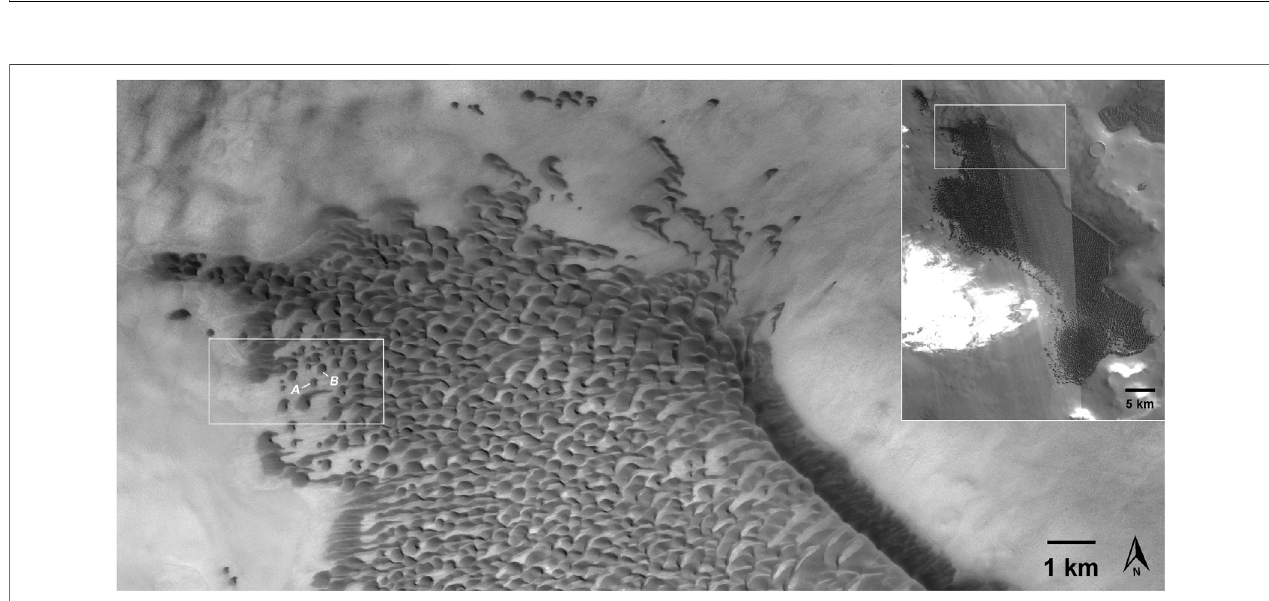
FIGURE3| Thenorthernendofthedune fi eld(CTXimageJ22_053517_2571),contextshownintheinset.Theboxindicatesthelocationof Figure1 ,andDunesA and B are indicated. The fi gure was made using JMARS (Christensen et al., 2009).